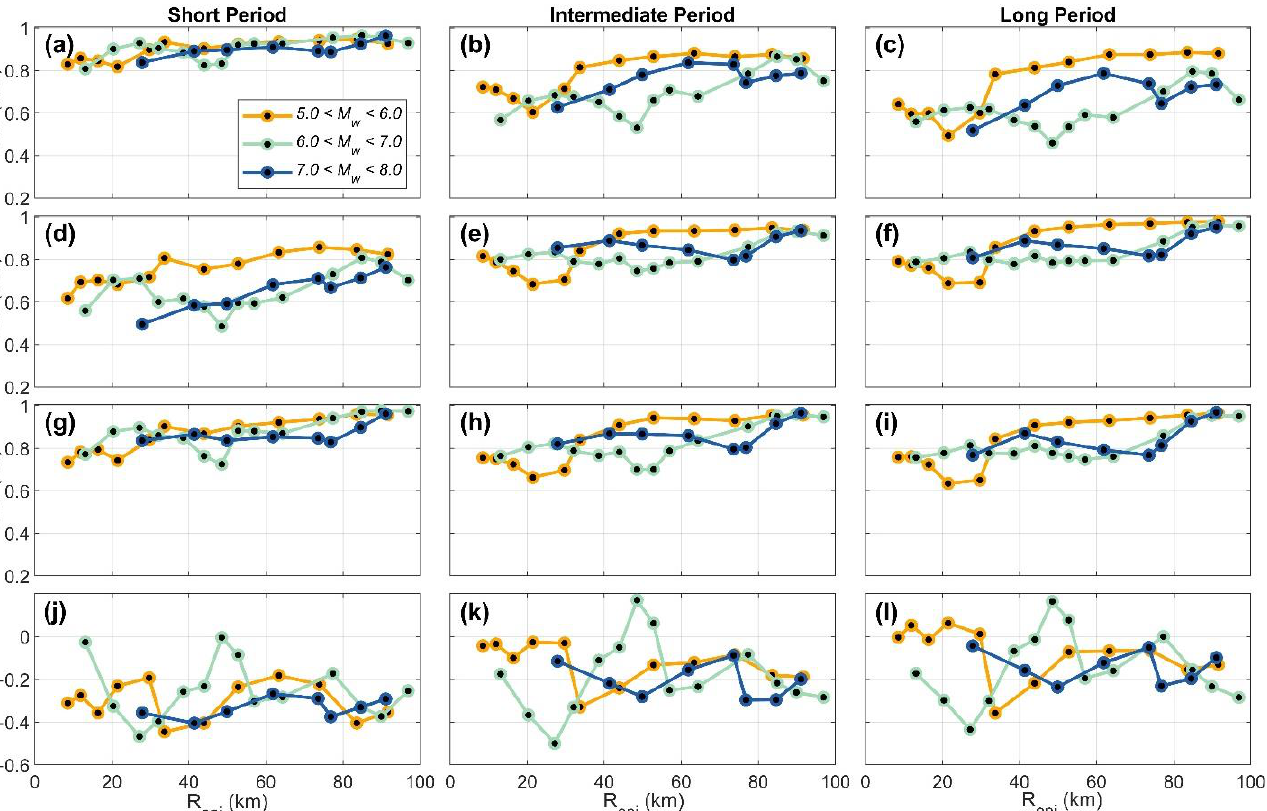
Figure 8. Distance-dependent correlations of spectral measures ( ASI , VSI , Sa(T) ) for different magnitude classes ( M w 5 – 6, M w 6 – 7 and M w 7 – 8) ( a – l ). Rows correspond to variations in correlations of ASI , VSI and Sa(T) for three different types of structures (SP, IP, LP). Correlations of ASI ( a – c ) and VSI ( d – f ) are almost invariant for SP and IP/LP structures, respectively, and do not show any noticeable magnitude dependence. Correlations of Sa(T) vary less for SP structures than IP or LP.